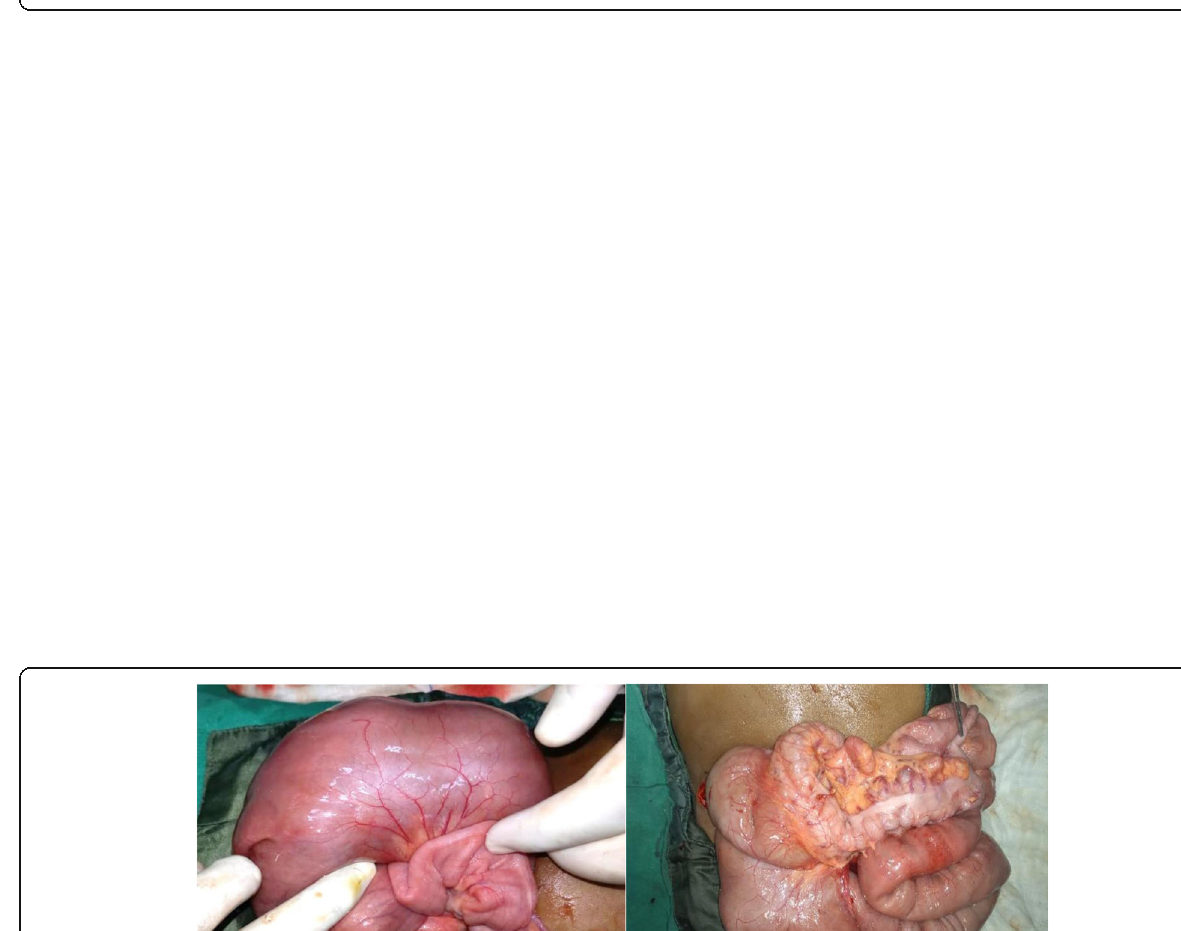
Fig. 2 a X-ray erect abdomen and pelvis of the patient. b Ultrasonography image showing the intussusception with an edematous thickened bowel wall